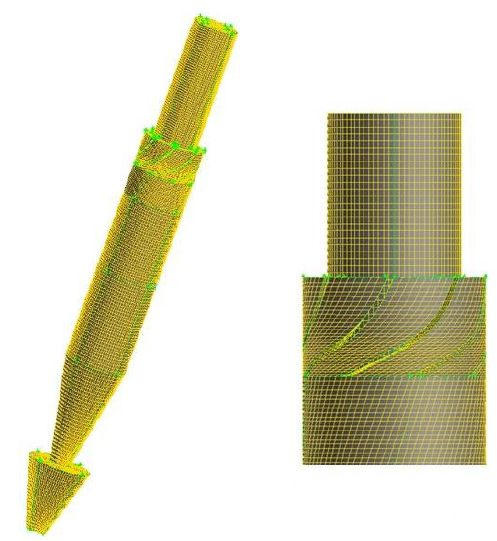
Figure 2. The axial flow cyclone separator mesh.